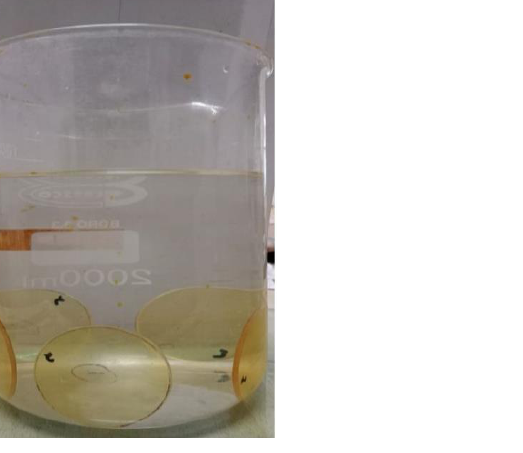
Figure 7. Water absorption specimens immersed in a container of distilled